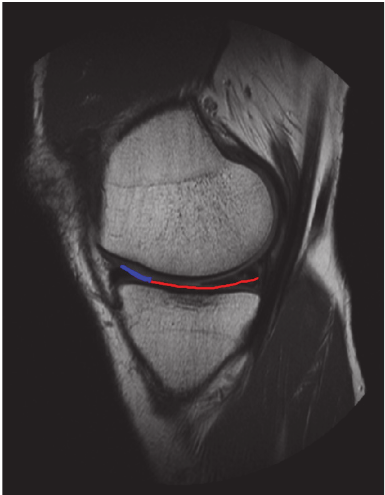
Figure 1: Cartilage flap indicated by red and blue line. The red line indicates the unattached, posterior two-thirds of the flap, and the blue line indicates the attached anterior third of the flap.